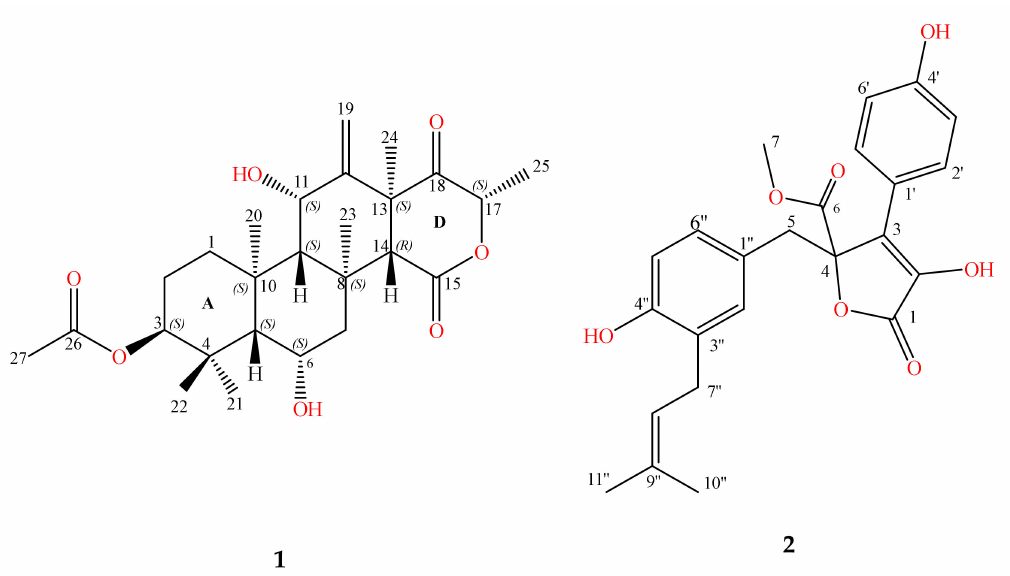
Figure 1. Chemical structures of terretonin N ( 1 ) and butyrolactone I ( 2